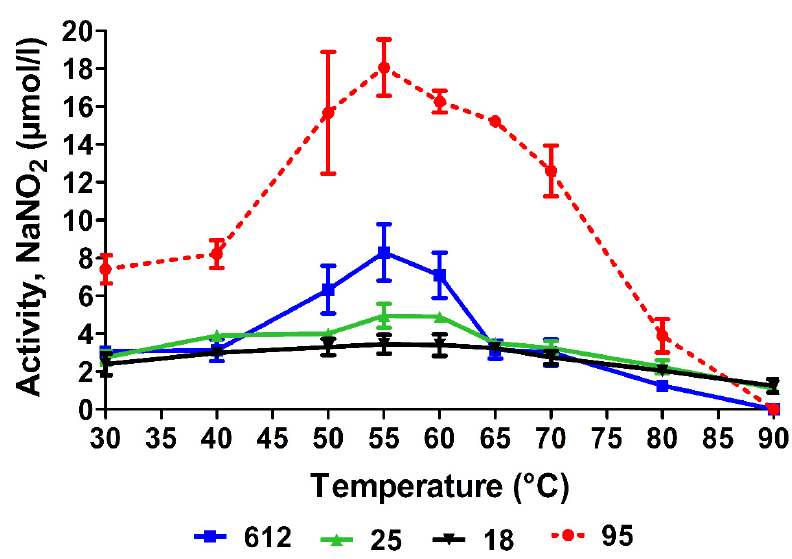
Figure 3. Nitrate reductase activity from different Geobacillus spp. strains at various temperatures. The activity is presented as the amount of formed NaNO 2 ( µ mol/L). 18, 25, 95, and 612—strain numbers.